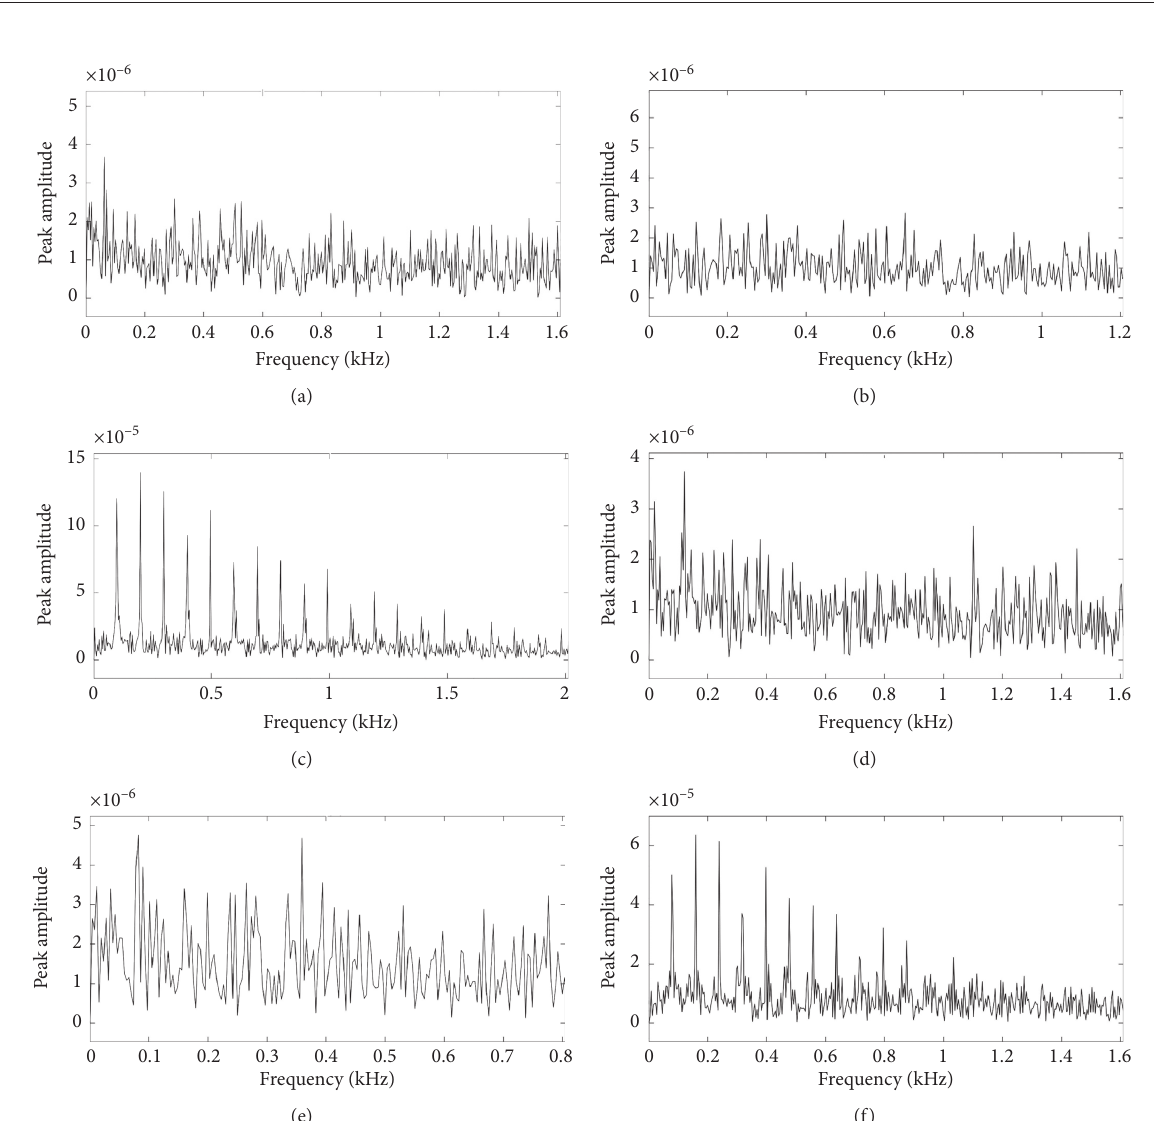
Figure 12: Envelope spectrum of signals before denoising. (a) Small defect, small load, and 600rpm. (b) Small defect, medium-low load, and 900rpm. (c) Small defect, medium-high load, and 1500rpm. (d) Large defect, small load, and 600 rpm. (e) Large defect, medium-high load, and 600rpm. (f) Large defect, high load, and